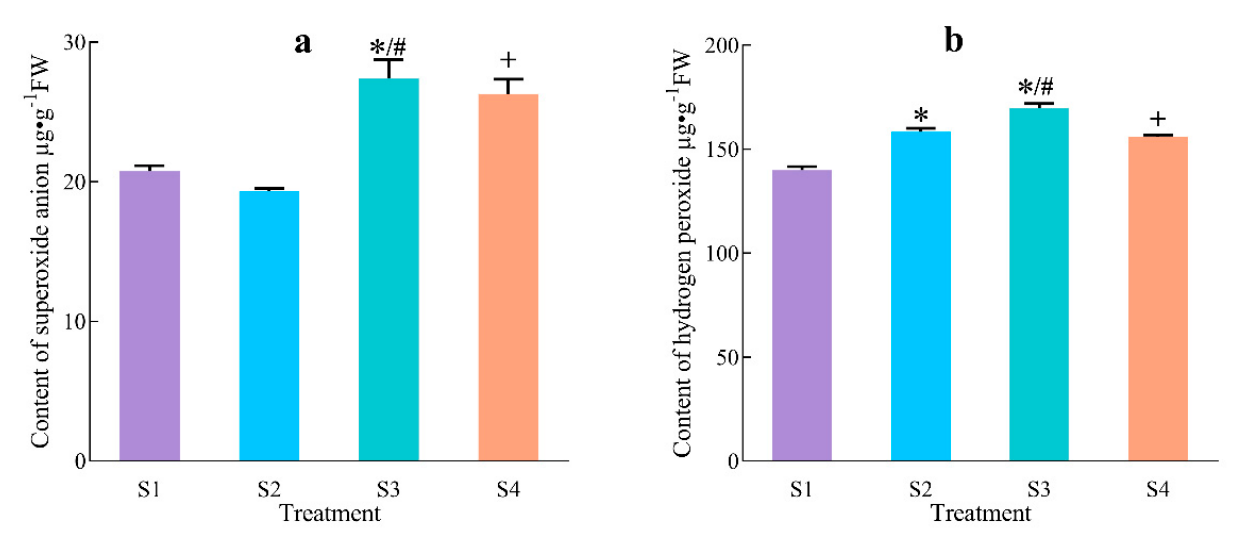
Figure 5. The main ROS content in the F. solani colony. ( a ) Superoxide anion (O 2 − ); ( b ) hydrogen peroxide (H 2 O 2 ). S1 group ( n = 3): inoculation of F. solani on PDA; S2 group ( n = 3): inoculation of F. solani on PDA containing 40 µ mol/L DPI; S3 group ( n = 3): inoculation of F. solani on PDA containing 40 µ mol/L DPI; S4 group ( n = 3): inoculation of F. solani on PDA and on the fourth day of cultivation, 5 mL of 0.0012% H2O2 was added to each dish. Data are expressed as mean ± SD. * p < 0.05 S2 or S3 vs. S1, # p < 0.05 S3 vs. S2, + p < 0.05 S4 vs. S1.